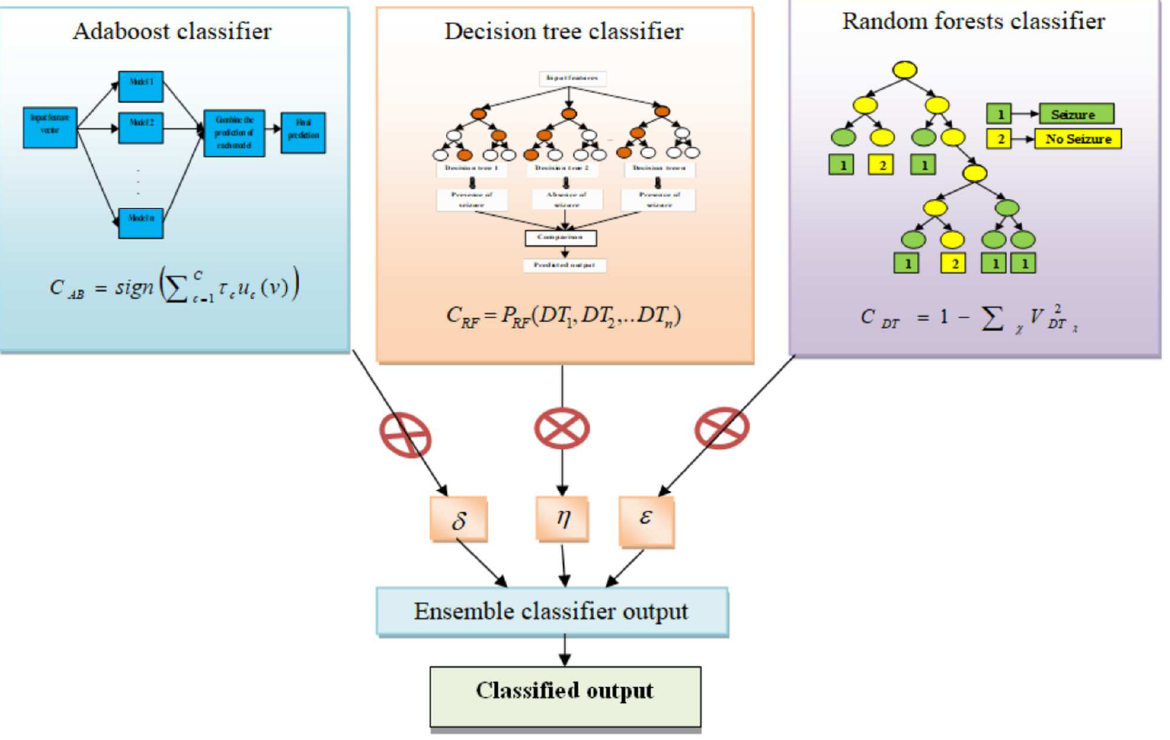
Figure 4. Proposed ensemble classifier for seizure prediction.